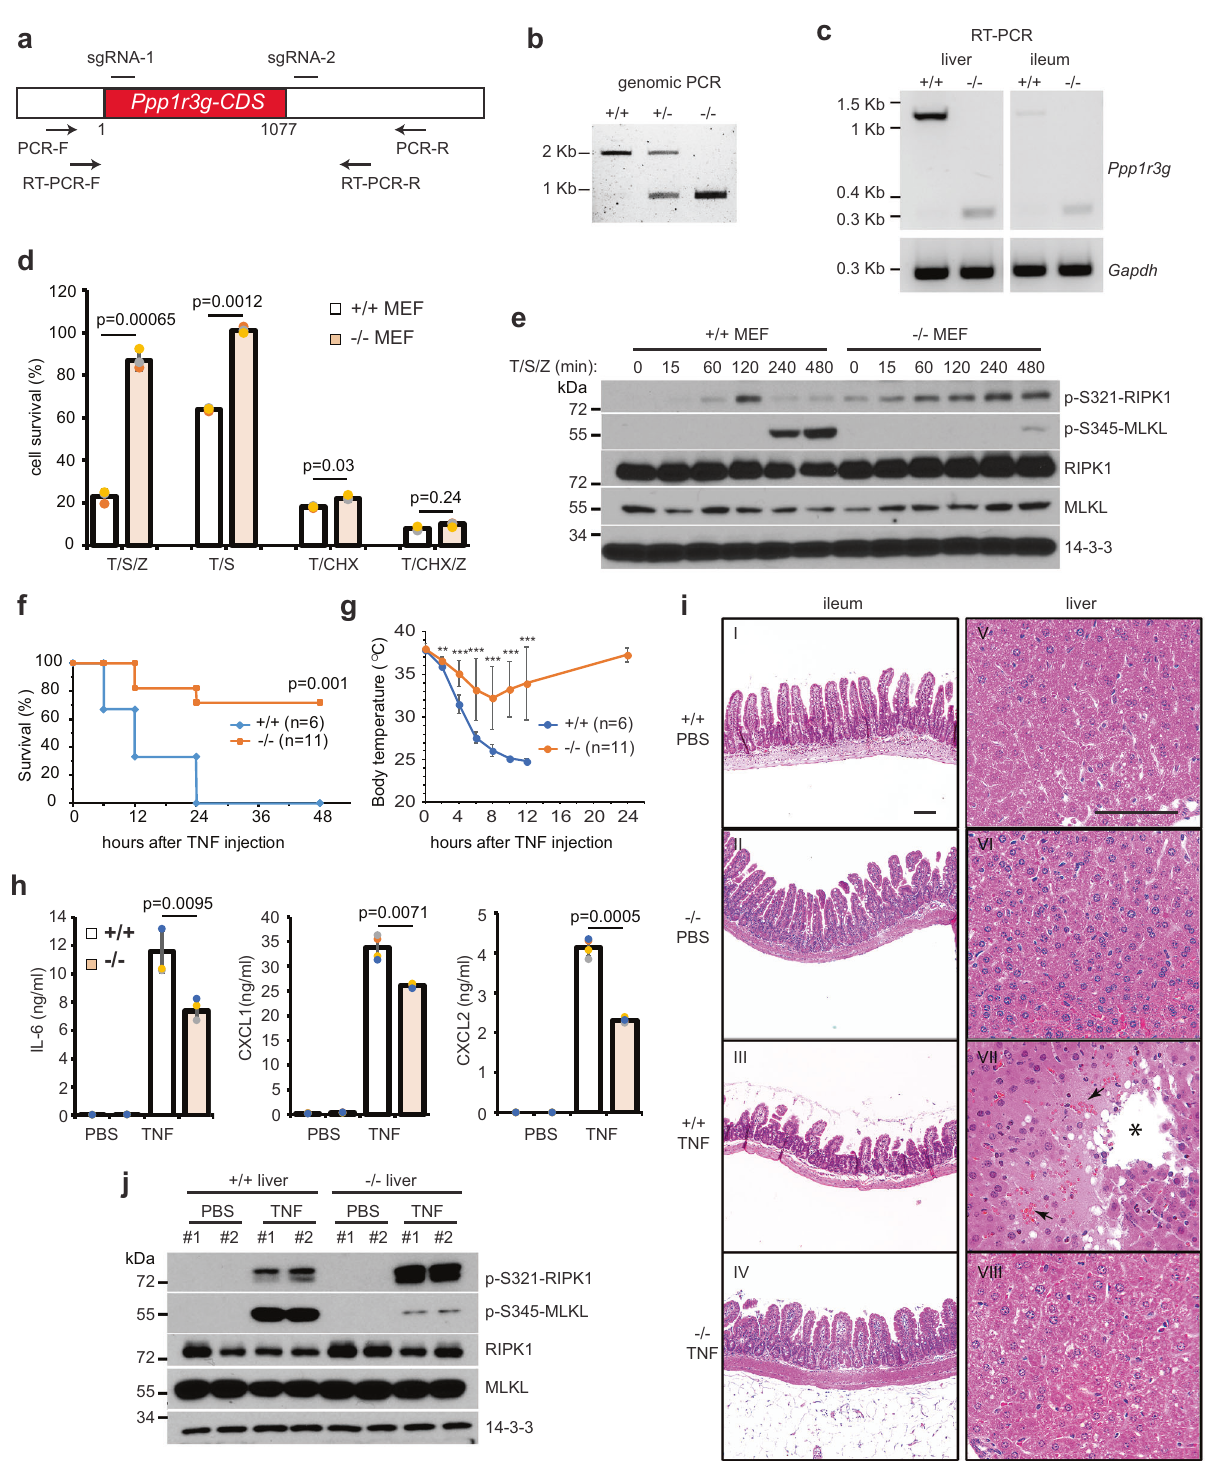
Cell culture and stable cell lines . HAP1 cells (Horizon Genomics) were cultured in IMDM supplemented with 10% FBS. HT-29 and MEF cells were cultured in CRISPR-mediated KO cell lines were generated as described before 61 . Brie fl y, gene- speci fi c targeting oligos were cloned into the LentiCRISPR V2 vector (Addgene